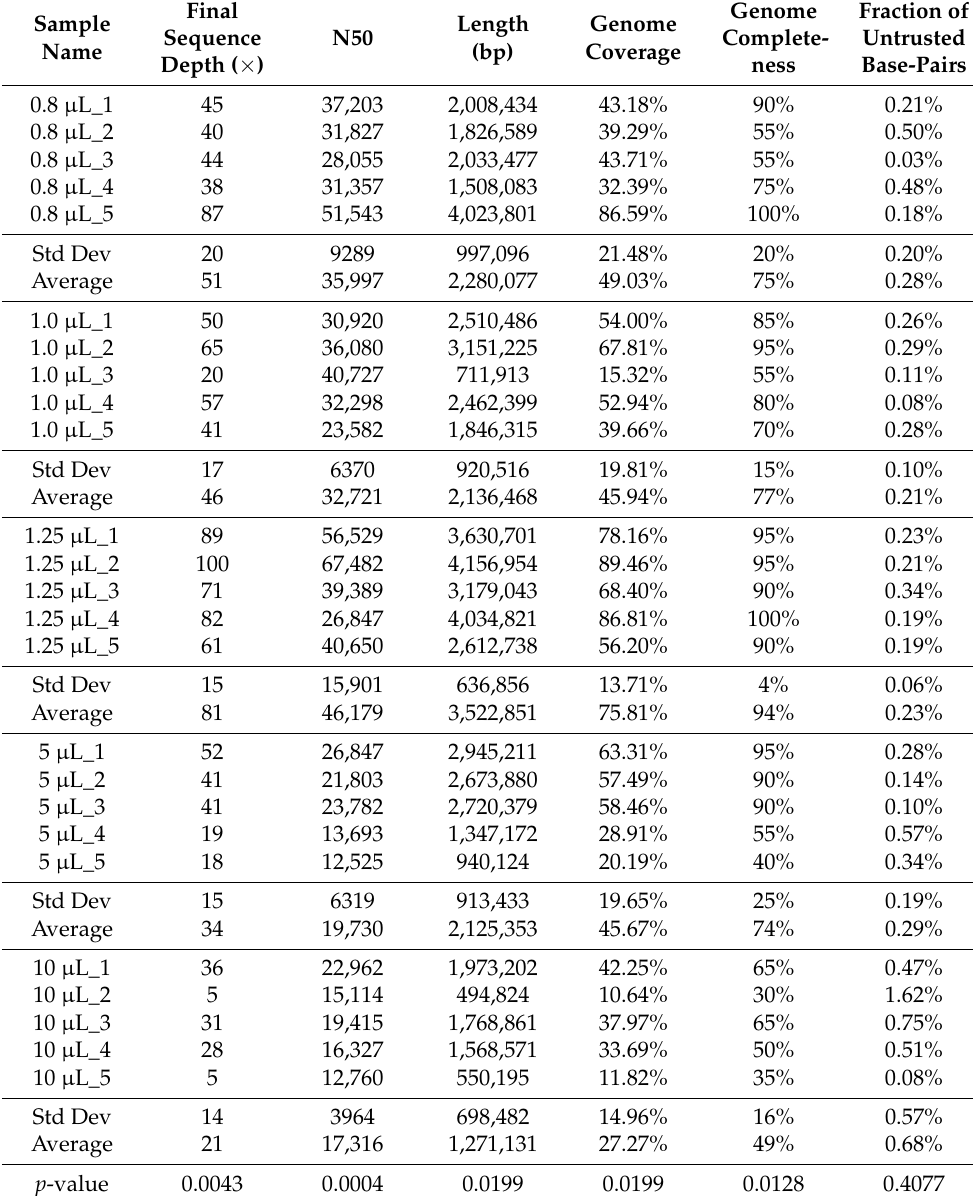
Table A5. MDA assembly summary. After read processing, the final sequence depth used for assembly was calculated. Assembly N50, length, and coverage were calculated using QUAST [70]. Coverage is calculated as the percent of contigs aligned to the reference genome. MDMcleaner was used to calculate completeness and assembly contamination [12]. p -values were calculated using one-way ANOVA with an alpha of 0.05 in Microscoft Excel ®